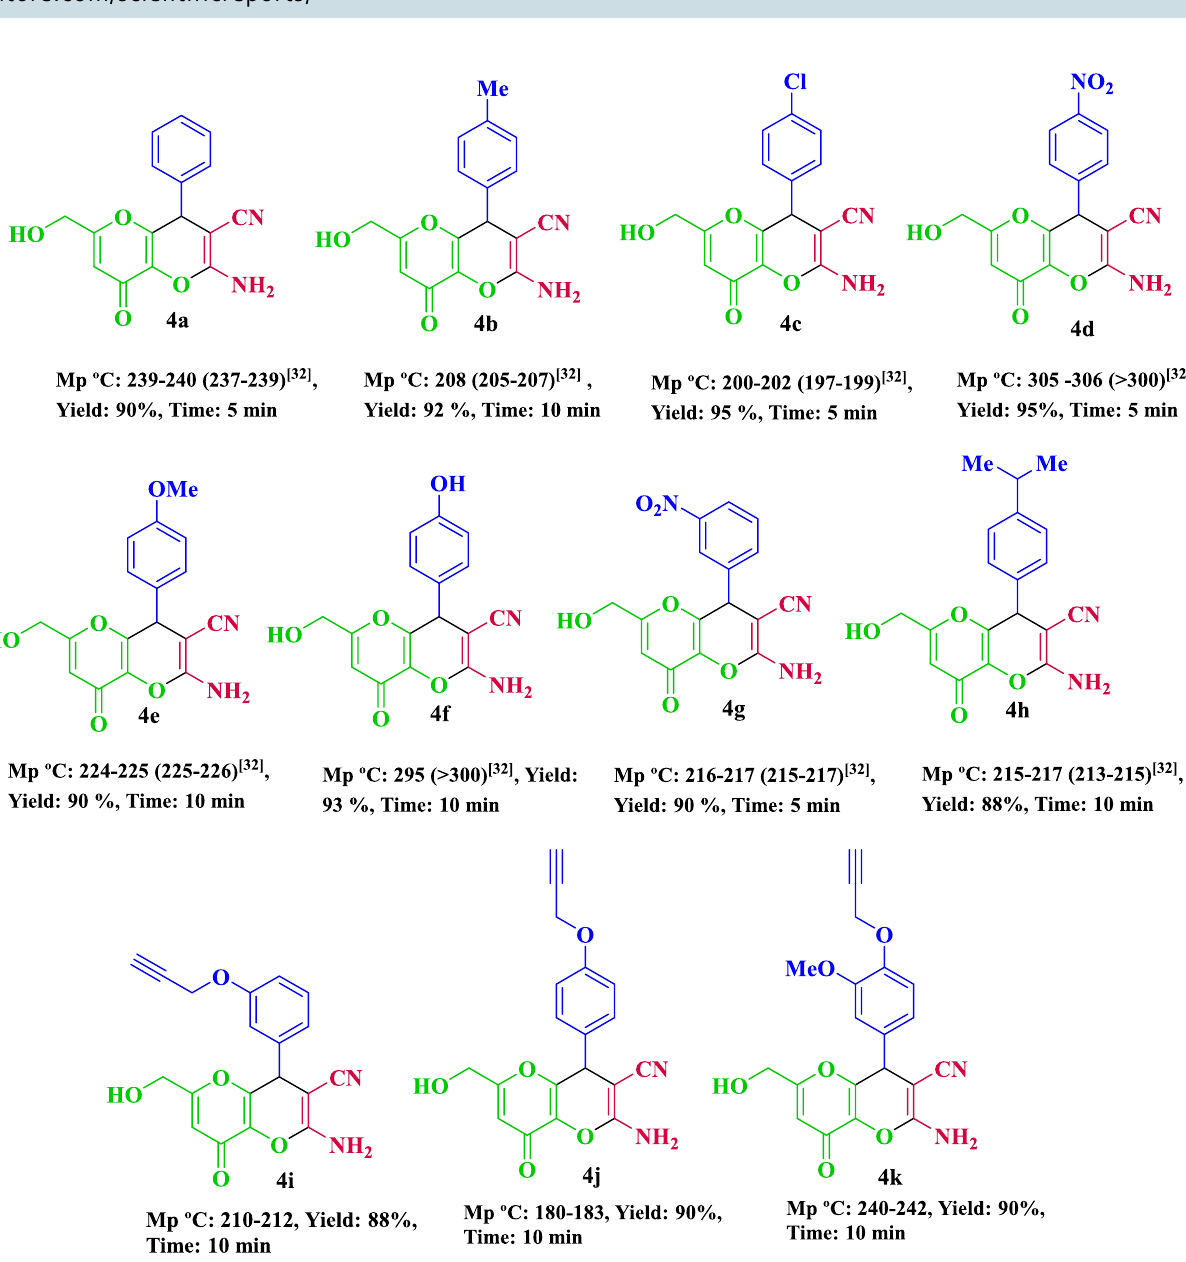
Figure 10. Synthesis of dihydropyrano[3,2- b ]pyrans using Fe 3 O 4